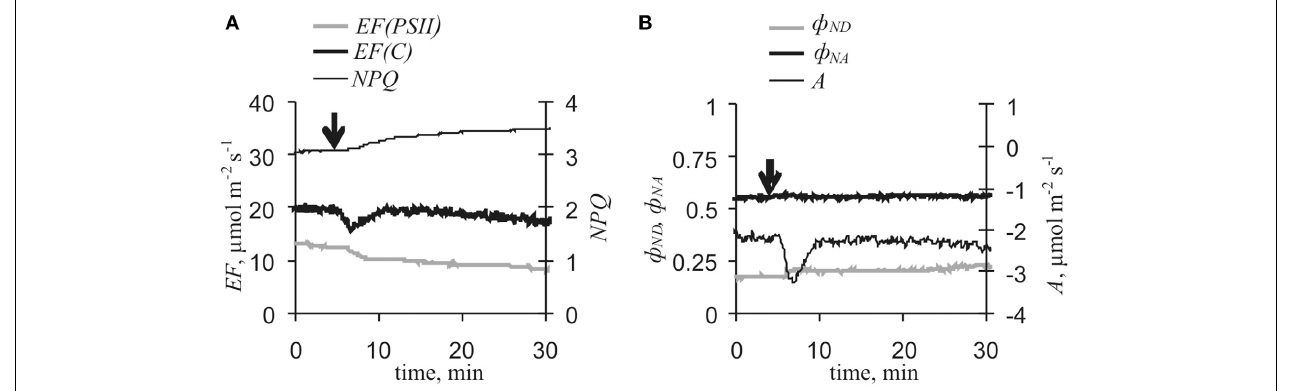
Table 2 | Correlation coefficients between changes in photosynthetic parameters induced by VP and [CO 2 ]-lowering.